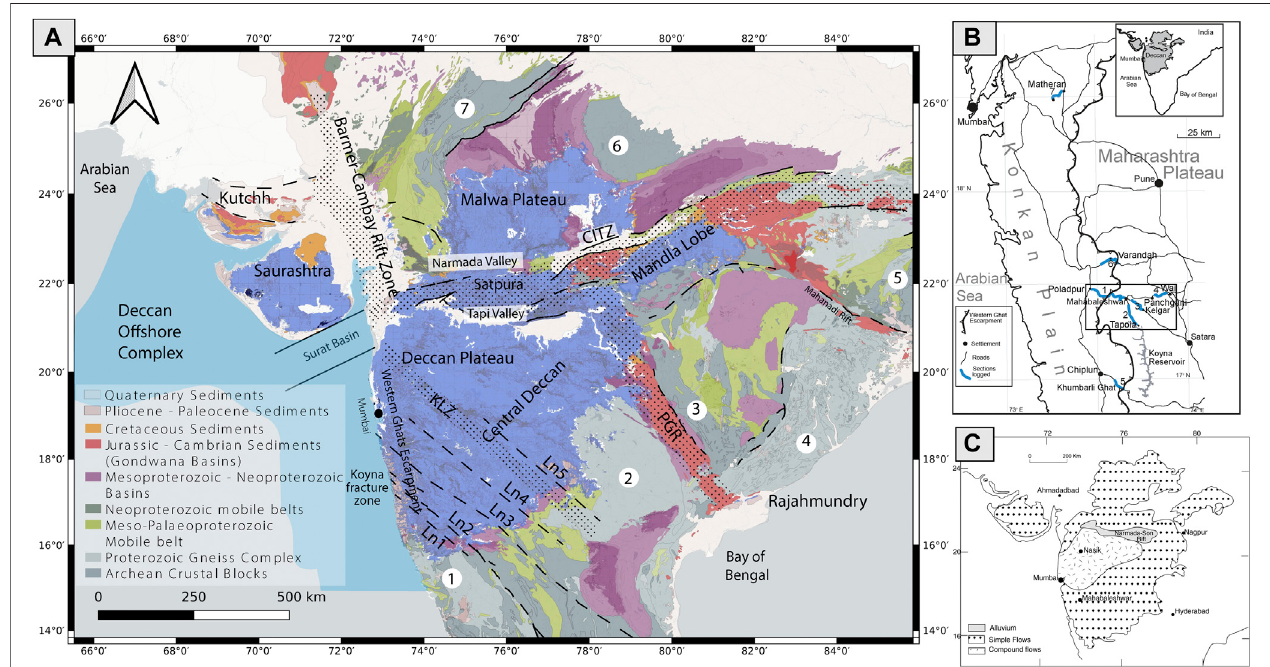
FIGURE1|(A) Simpli fi edgeologicmapofIndiashowingdistributionofmainoutcropsofDeccanVolcanicProvince(DVP)andmainsub-provinces(DeccanPlateau including the Western Ghats), Satpura region, Mandla Lobe, Malwa Plateau, and Kutchh-Saurashtra region (blue color). Figure also shows major sedimentary basins (with Gondwana basins highlighted in red), Proterozoic mobile belts, and major cratons: 1: Western Dharwar Craton, 2: Eastern Dharwar Craton, 3: Bastar Craton, 4: EasternGhatsBelt,5:SinghbhumCraton,6:BundelkhandCraton,7:AravalliCraton.Primarytectonicfaultsandlineaments(dashedlines)inCentralIndiarelatedto pre-existing Indian crustal features are: Barmer-Cambay rift zone, Central India Tectonic Zone (CITZ), Pranhita-Godavari rift zone (PGR), Kurduwadi Lineament zone (KLZ), Western Ghats Escarpment, Koyna Fracture Zone, and Ln 1-5 (lineaments inferred based on integrated analysis of gravity and magnetic data, Rajaram et al., 2017). (B) Map ofWesternGhatsarea where majority ofDVP data comes from, after Jay (2005); traverses for lava data shown in blue (see Figure 4 ). (C) Sketch map of DVP showing Deshmukh (1988) distribution of simple and compound lavas. Mumbai is located on all three